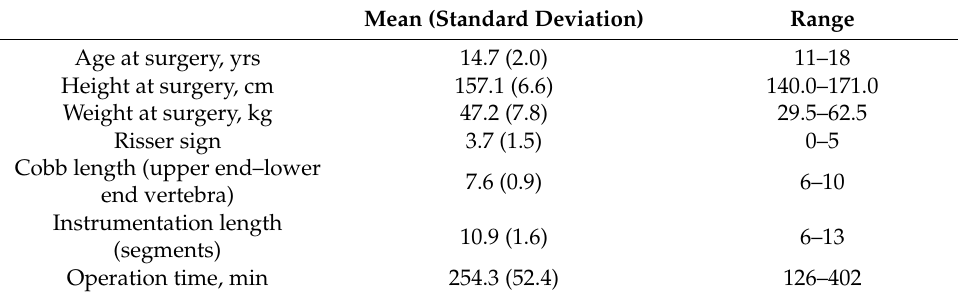
Table 1. Patient demographic